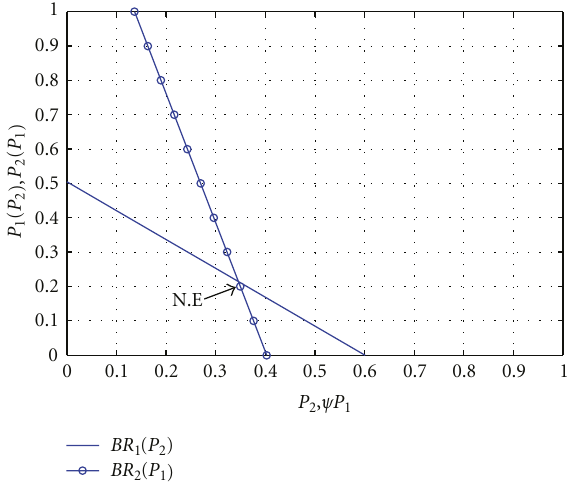
Figure 9: Best response functions illustrating the unique Nash equilibrium point where both operators transmit in both carriers.